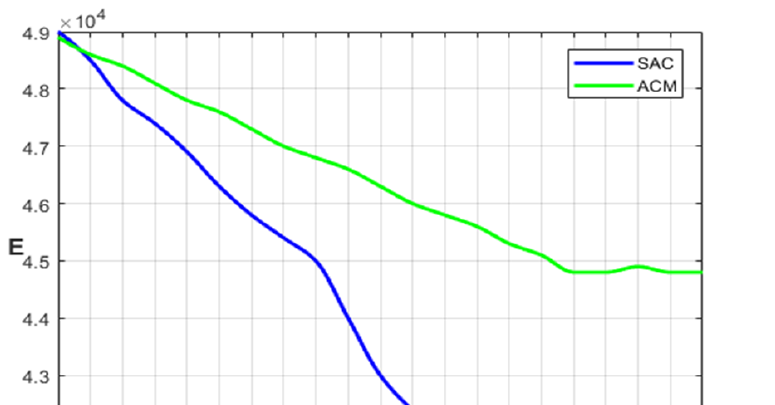
Figure 7. Robustness experiment.